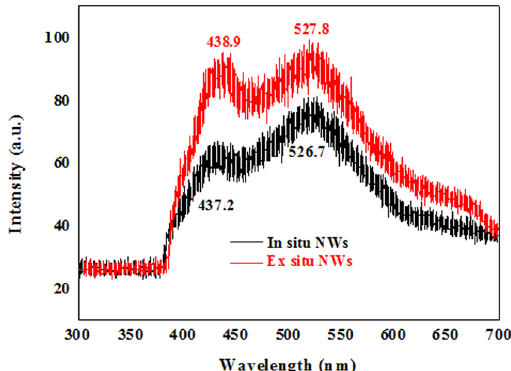
Figure 4. PL spectra of the SiC NWs obtained at different locations under the excitation of a 325 nm He-Cd laser at room